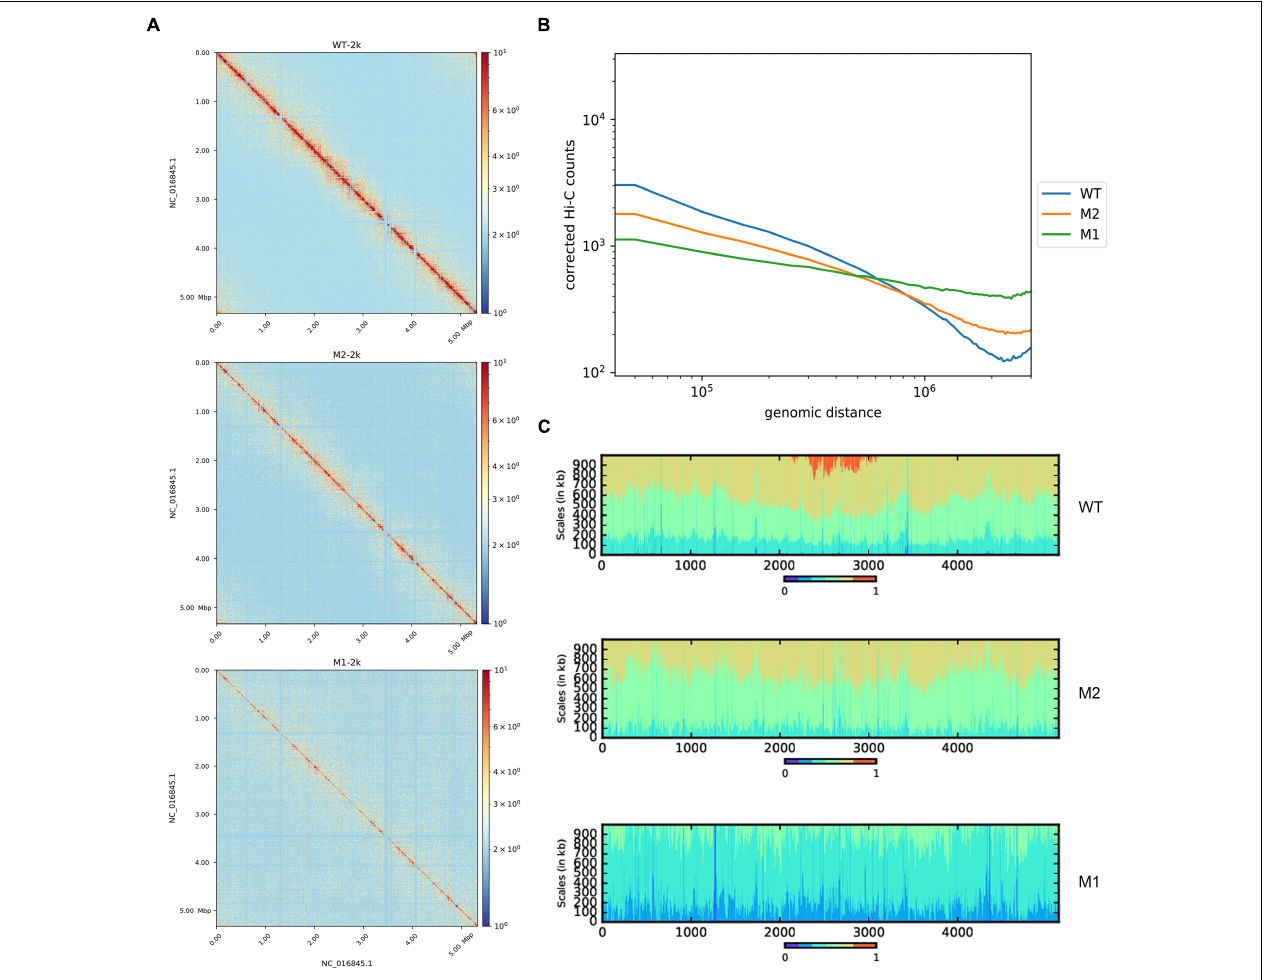
FIGURE 1 | Whole-chromosome organization of WT, M1, and M2. (A) Chromosome contact map of WT, M1, and M2 after normalization (2 kb resolution), x and y axes represent genomic coordinates. The color scale indicates the contact frequency between chromosome regions. Blue indicates low contact frequency and red indicates high contact frequency. (B) Chromosome interaction frequency and genomic distance. (C) Scalogram representation. Scalograms reflect the relative compactness of the contact distribution of chromosome regions. The colored areas above each bin represent the fraction of the total cumulated contacts made by the bin with flanking regions of increasing sizes (dark blue, 0–15%; light blue, 15–30%, etc.; red, 75–100%). Constrained regions display small blue and large red areas. Loose regions display large blue and small red